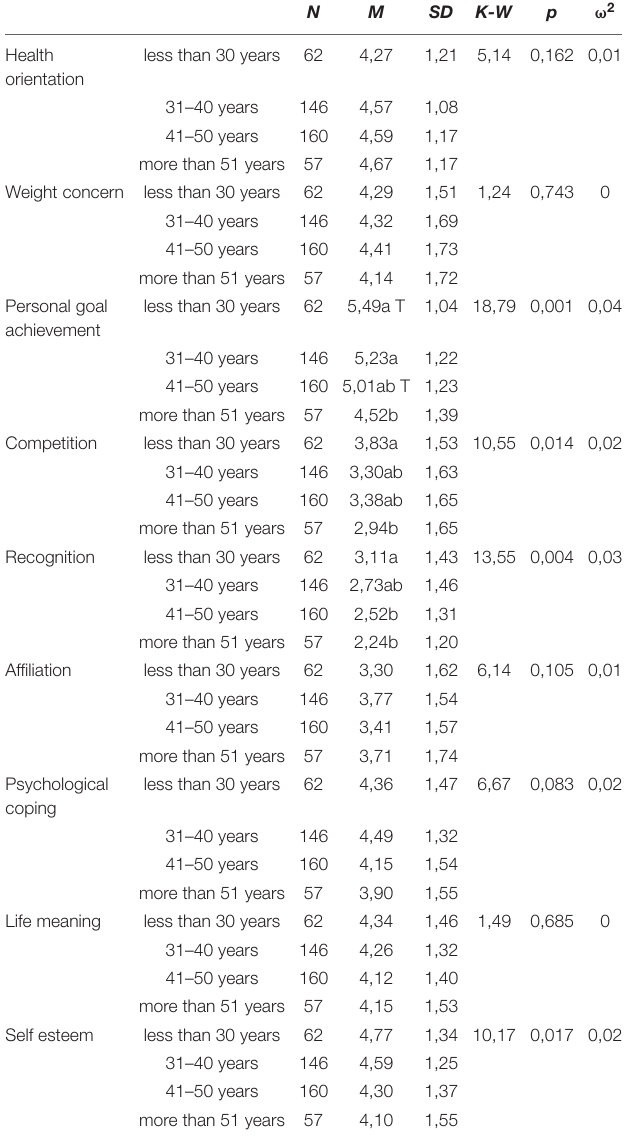
TABLE 4 | Comparison of the level of motivation scales of ultramarathon runners not competing in marathons in different age groups. N M SD K-W